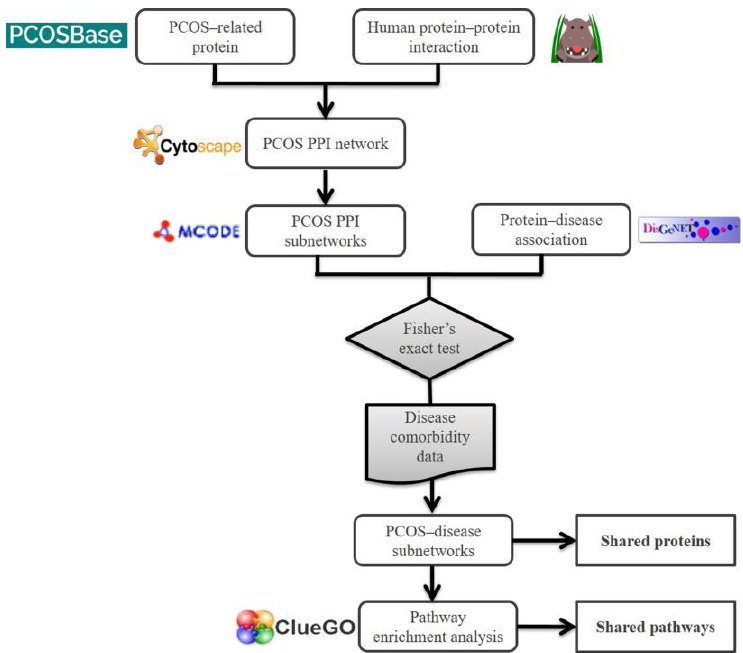
Figure 7. Framework of the computational method used to elucidate the association of PCOS with other diseases.